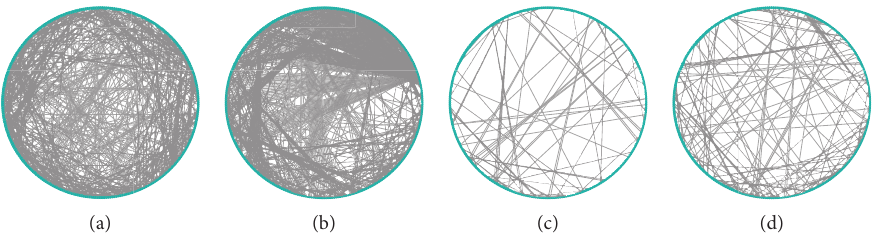
Figure 4: Visualization of four random networks with N � 300. (a) ER_300_0.015. (b) BA_300_2. (c) WS_300_3_0.2. (d)